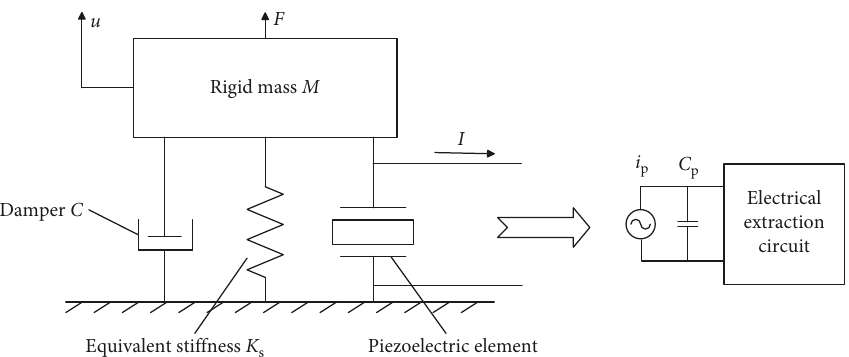
Figure 1: Electromechanical coupling model.